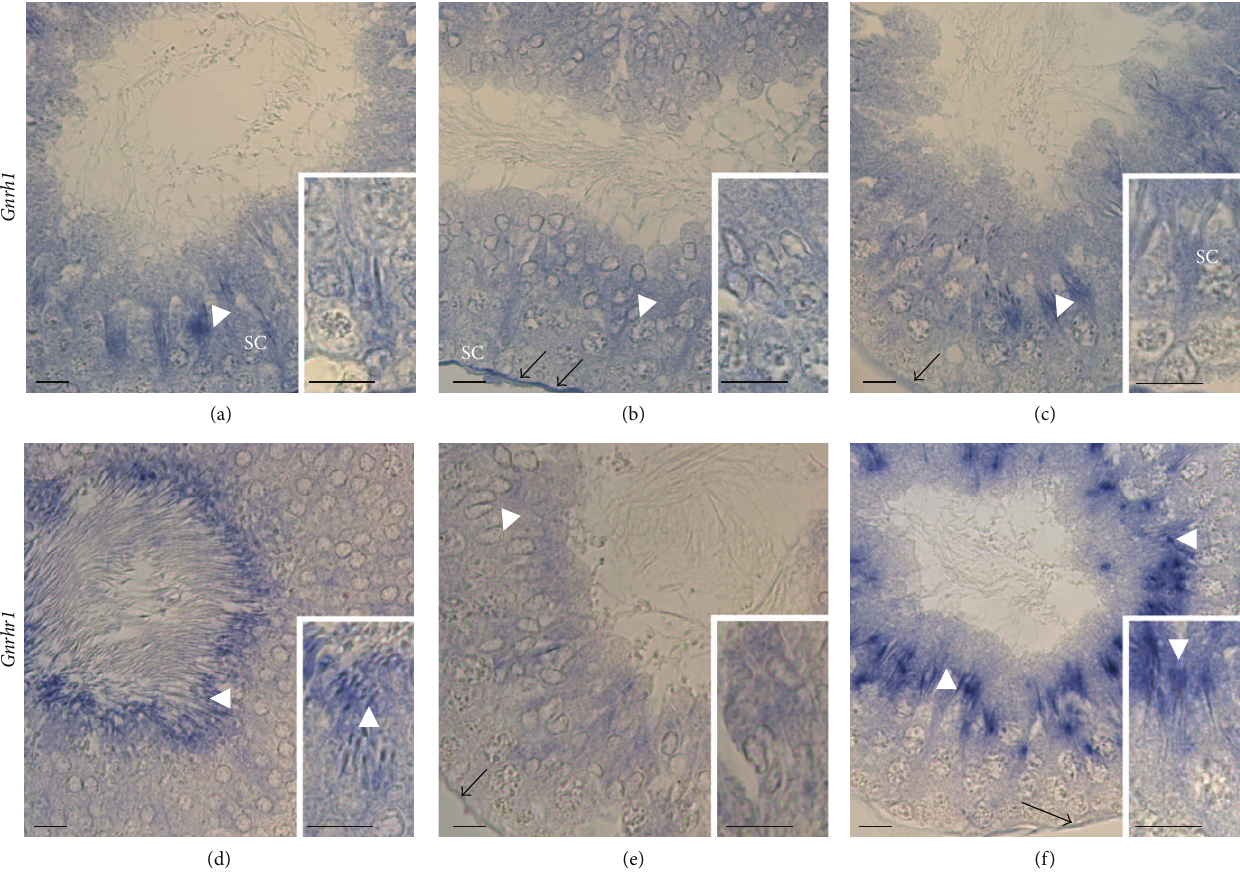
Figure 3: Localization of Gnrh1 and Gnrhr1 by in situ hybridization in rat testis during the stage of the spermatogenetic cycle ((a)–(f)). The blue staining indicates the positive cells; few of them, representative of the different cell types, are pointed out by white arrowhead, SPT ((a)– (f)); black arrow, peritubular myoid cells ((b), (c), (e), and (f)); SC, Sertoli cells. The insets are shown in 100x magnification. Scale bars: 20 𝜇 m. The results are representative of one of three